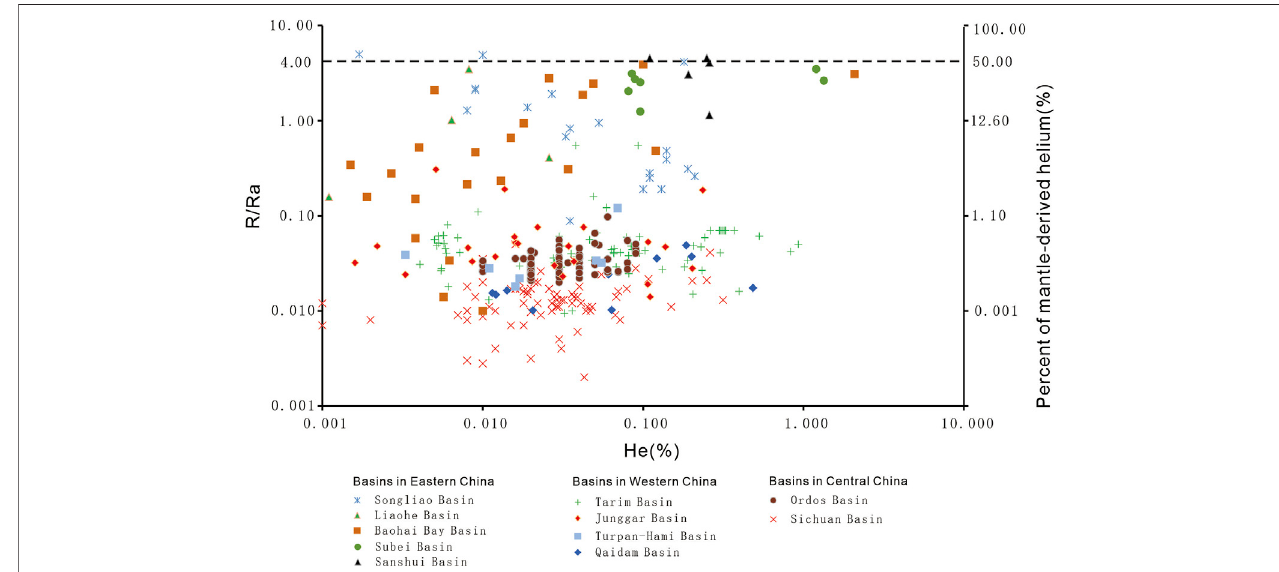
FIGURE 2 | Relationship between helium contents and R/Ra rations in major petroliferous basins in